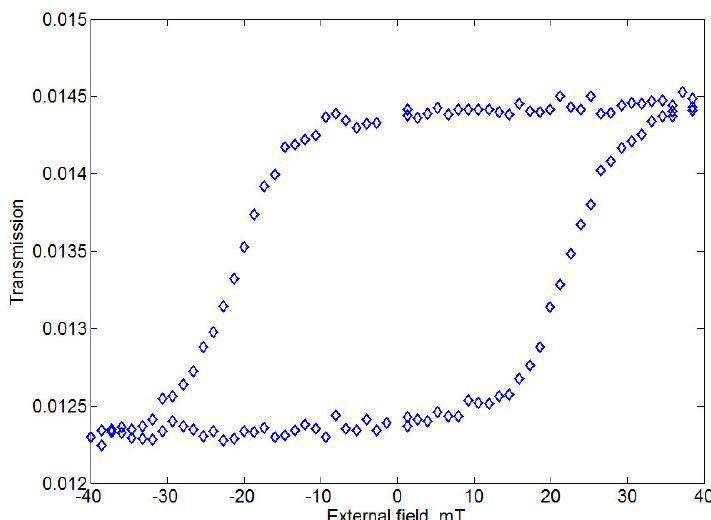
Figure 7. Transmittance-mode Faraday hysteresis loop for the sample-4 with Ag layer on